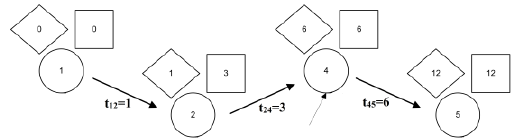
Figure. 1 Passenger transportation network along with activities and